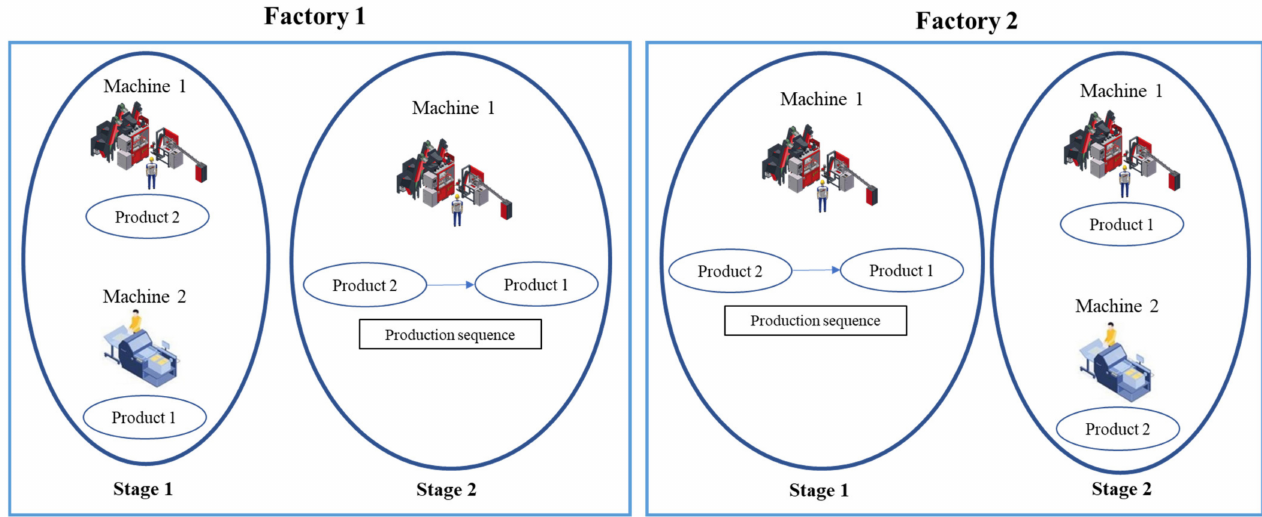
Figure 2. The allocation and sequences of products in each stage of the